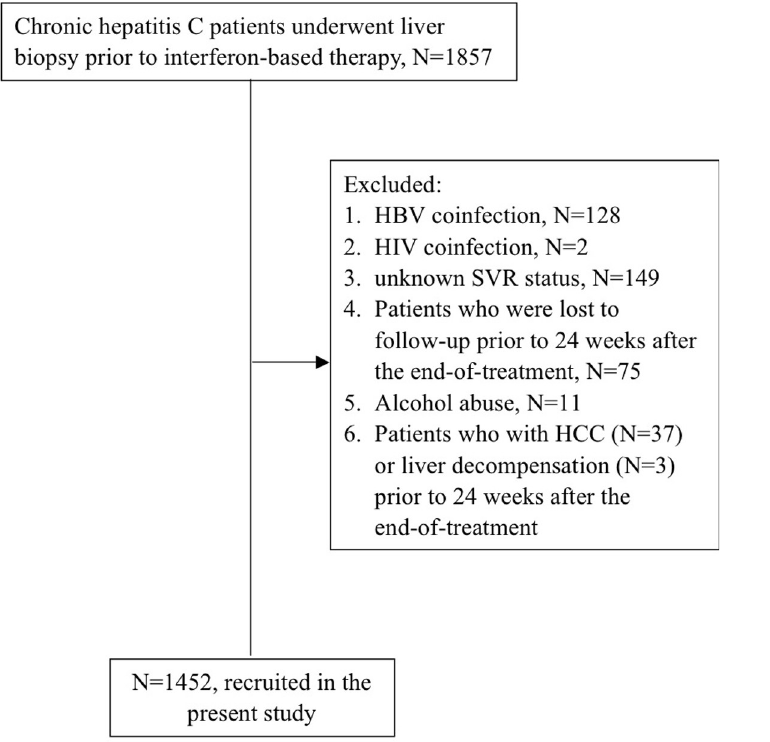
Fig 1. The inclusion and exclusion of potential subjects for this